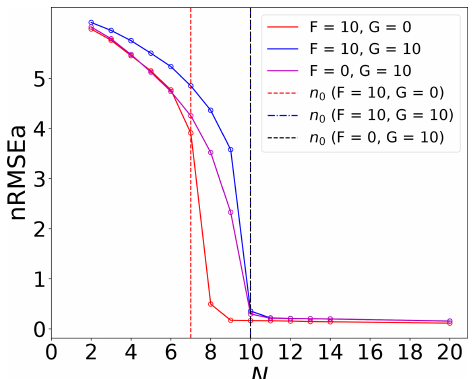
Figure 1. Time series of nRMSEa over the first 100 time units (2000DA cycles) using α = γ = 1 on n/ 2 = 18 grid points with an ensemble size of N = 40 with the entire state vector observed at every time step.